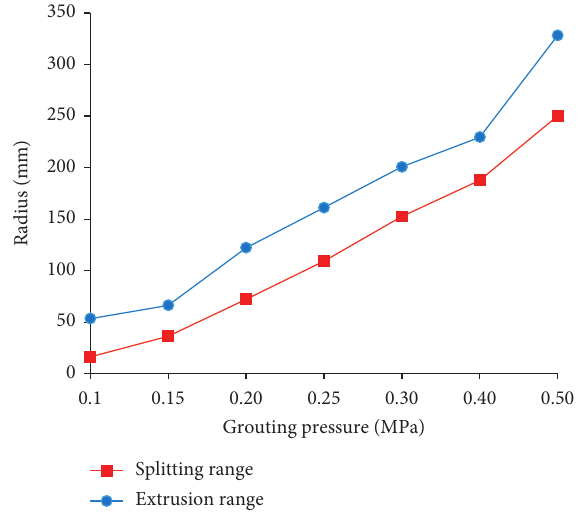
Figure 5: Grouting splitting range and extrusion zone range change.